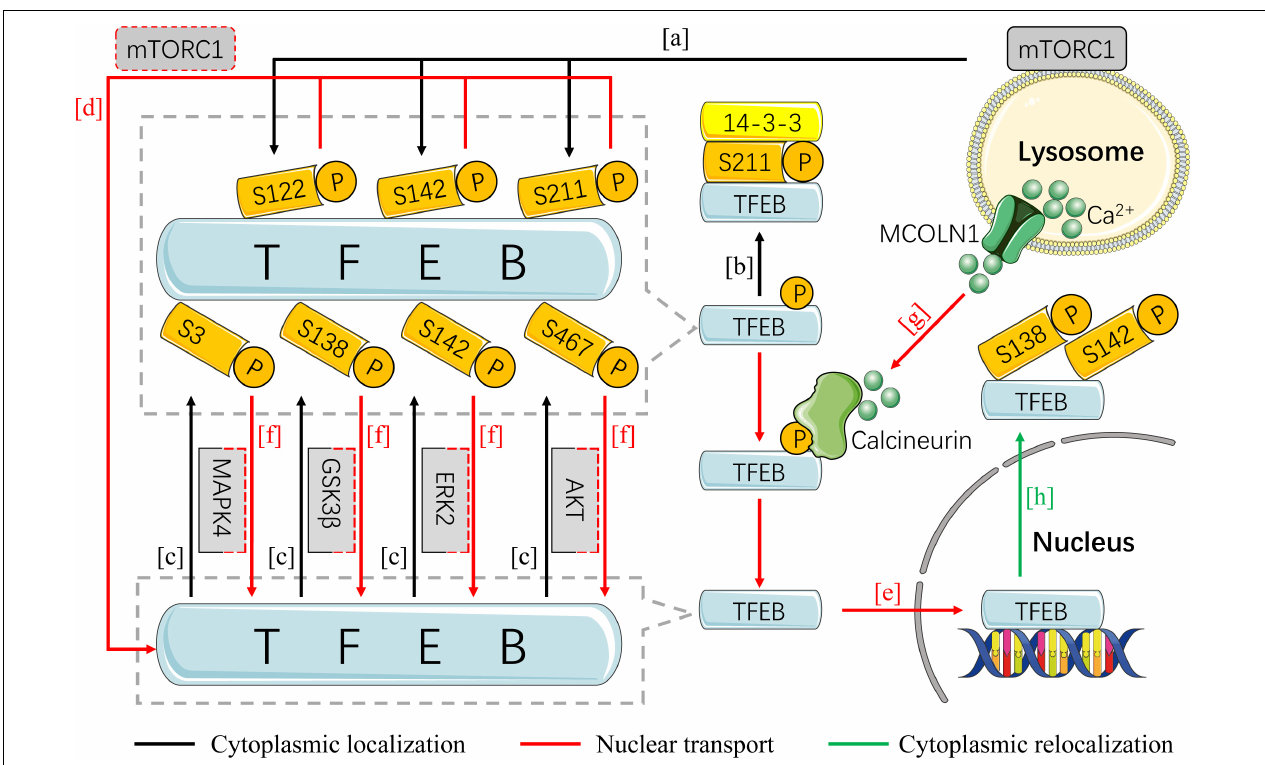
FIGURE 1 | The regulation of TFEB activity by phosphorylation. In the condition of nutritional sufficiency, TFEB is isolated outside the nucleus in an inactive state by phosphorylation and accumulates in the cytoplasm. TFEB can be phosphorylated by mTORC1 on S122, S142, and S211 (A) , by AKT on S467, and by GSK3 β on S138, by ERK2 on S142, and by MAPK4 on S3 (C) . The phosphorylated TFEB on S211 is recognized and bound by YWHA/14-3-3 protein in atypical patterns (B) . When encountering with starvation or stress, the withdraw of any phosphorylation site is sufficient to induce TFEB activation and nuclear transport (D,F) . Calcineurin is stimulated by the Ca 2 + released from the lysosome in MCOLN1-dependent way and is primarily responsible for the dephosphorylation of TFEB (G) . Dephosphorylated TFEB transfers to nucleus and further initiates the transcription of target genes (E) . Refeeding after nutrition deprivation, TFEB initiates cytoplasmic relocalization in a short time by hierarchical phosphorylation on S142 and S138 (H) . (AKT, protein kinase B; ERK2, extracellular regulated protein kinase 2; GSK3 β , glycogen synthase kinase 3 β ; MAPK4, mitogen-activated protein kinase 4; mTORC1, mammalian target of rapamycin complex 1; TFEB, transcription factor